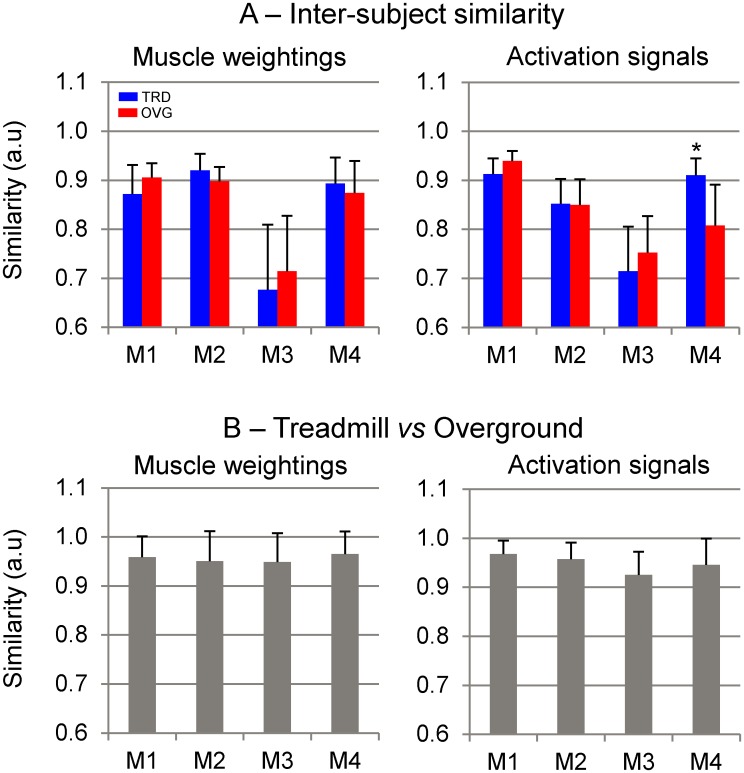
Motor modules—similarities.A: inter-subject similarities (Mean±SD) across the four identified muscle weightings and activation signals during treadmill running (grey) and overground running (black). B: intra-subject similarities between treadmill and overground running. * denotes significant difference in relation to overground running.